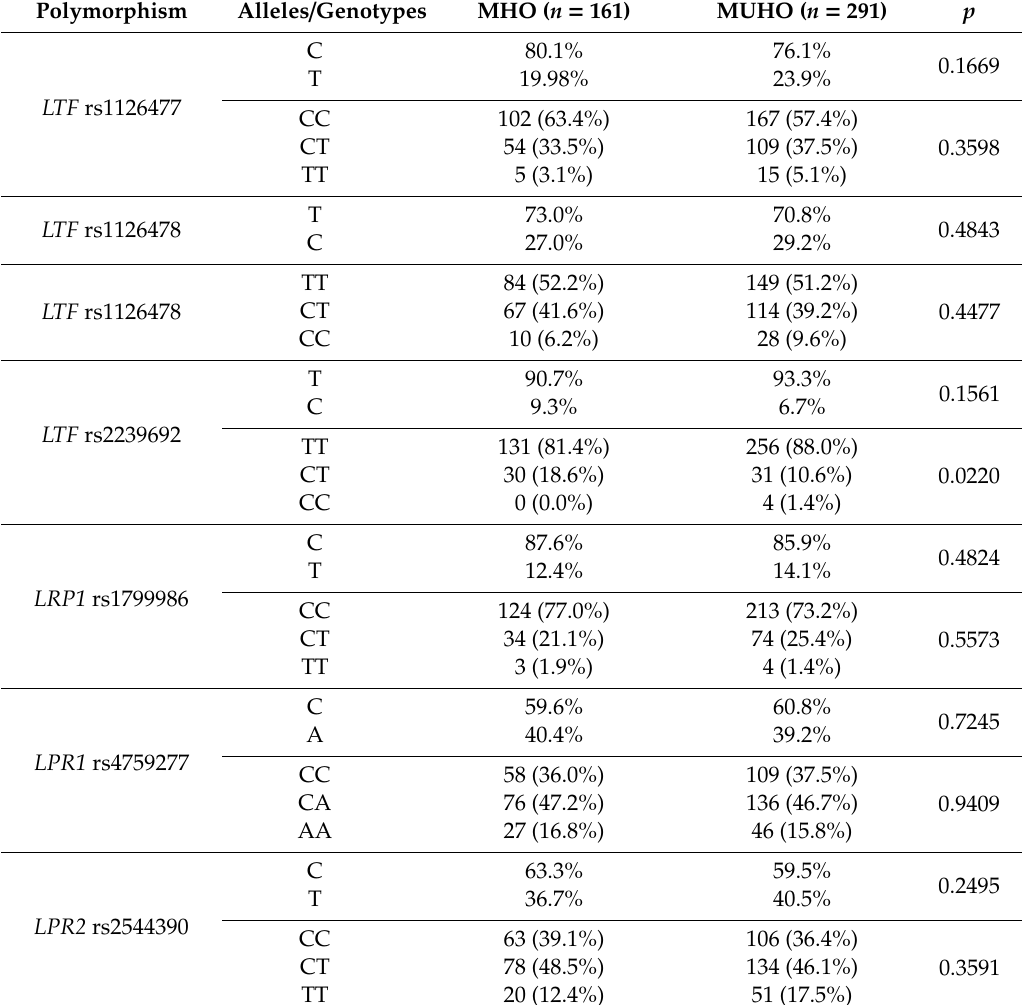
Table 3. Distribution of alleles and genotypes in analysed gene polymorphisms in MHO and MUHO